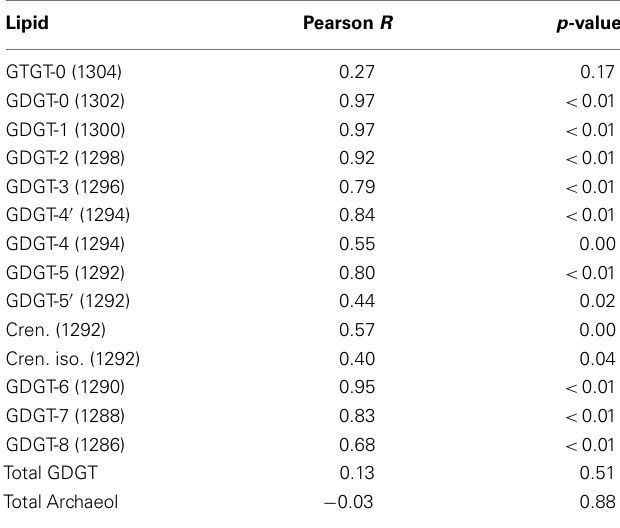
Table 5 | Pearson correlation between the relative abundance of GDGT and archaeol lipids in the C- and P-fractions in 26 geothermal spring